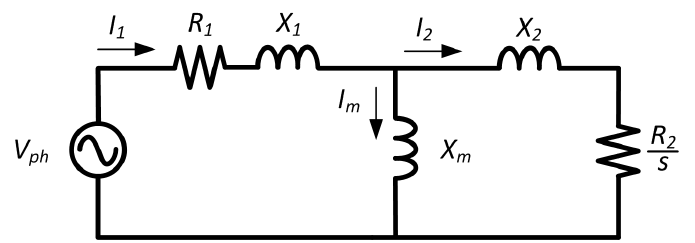
Figure 1. IM steady-state equivalent